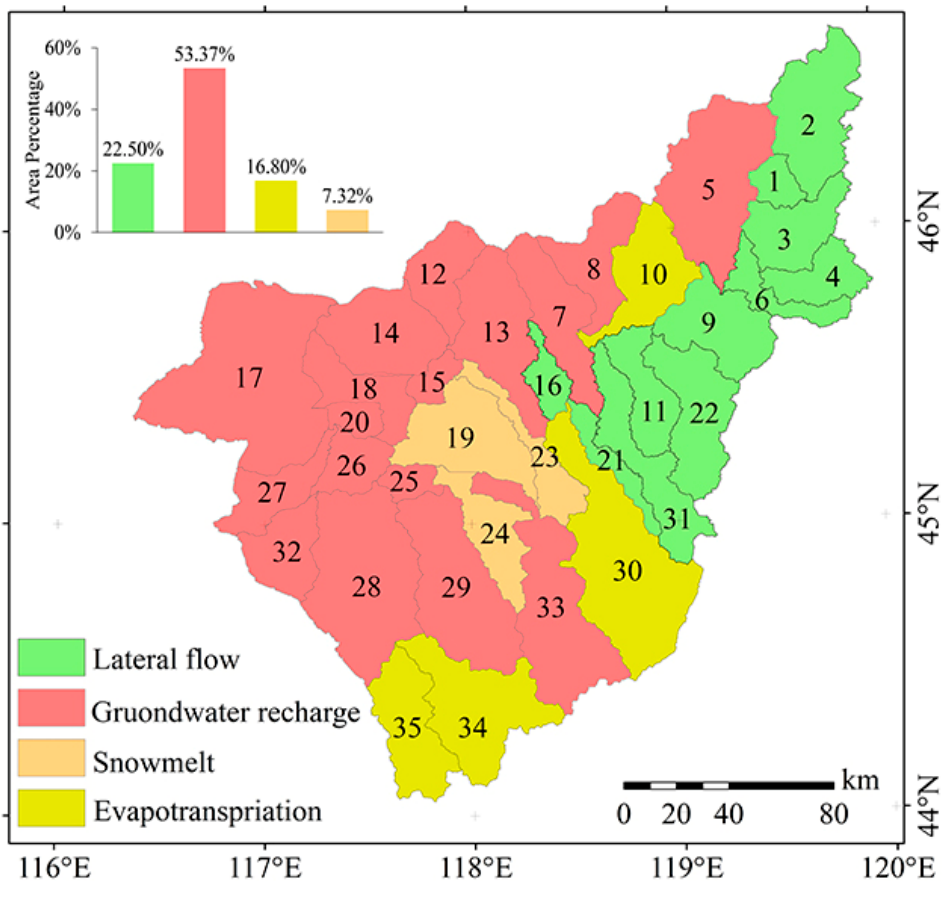
Figure 10. Spatial distribution of the URB’s strongest synergistic hydrological process factors for EQ changes.